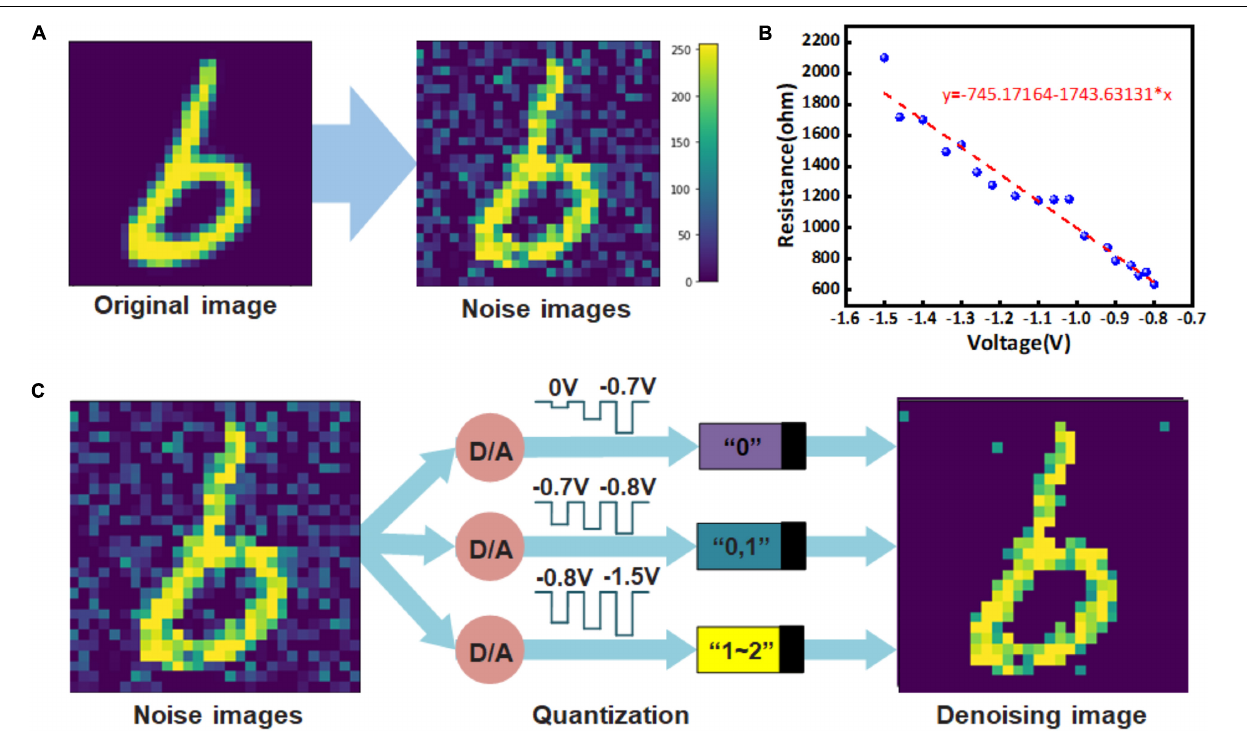
FIGURE 3 | (A) An example to show that the original features of an image are reduced after the noise is added. The change in color from dark to light indicates a change in pixel value from 0 to 255. (B) The curve is obtained by linear fitting of the measured multi-resistance states of Pt/ZnO/Pt memristor as a function of voltage. (C) The process of image denoising by